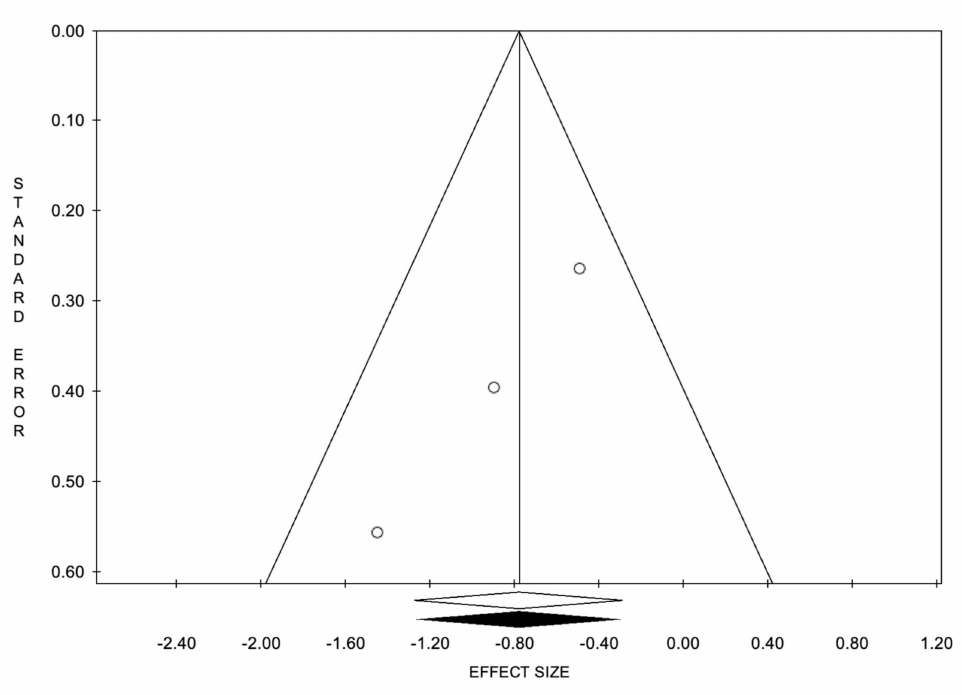
Figure 5. Funnel plots of the meta-analysis evaluating the event rate for 2-year progression-free survival. Egger’s linear regression (t= − 28.93, p = 0.022) and Begg and Mazumdar’s rank correlation test (z = − 1.57, p = 0.117).